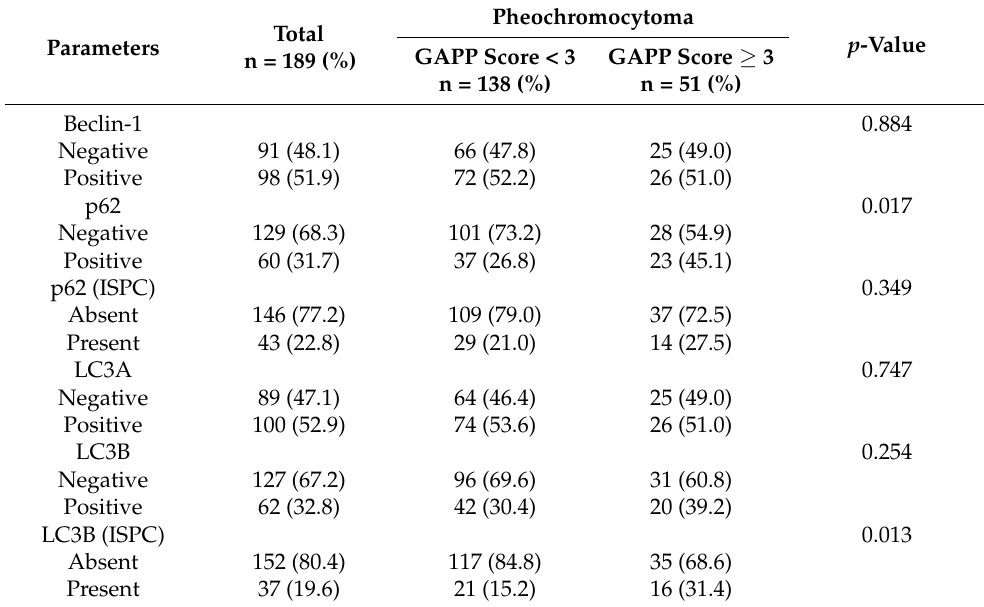
Table 3. Expression of autophagy-related proteins in pheochromocytoma according to GAPP